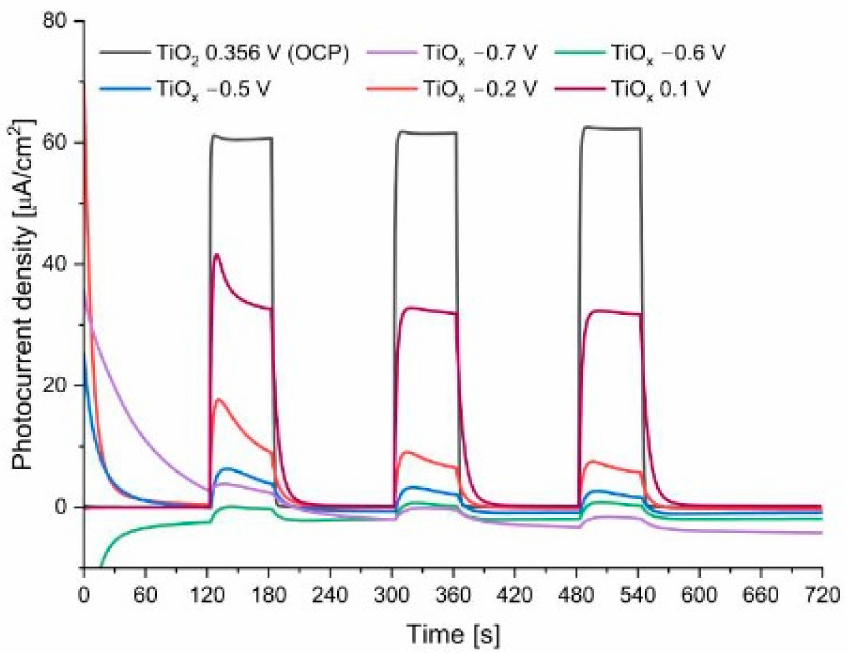
Figure 7. Photocurrent density vs. time curves under chopped simulated sunlight illumination for non-reduced TiO 2 and reduced TiO x samples at various OCP